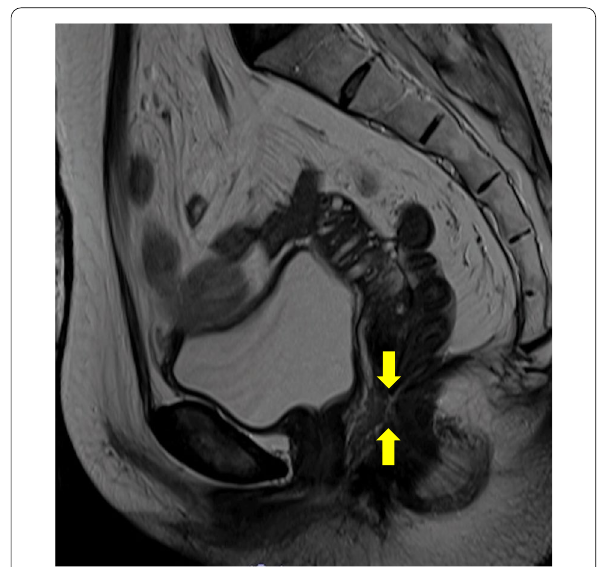
Fig. 2 Magnetic resonance imaging shows a fistula between the rectum and vagina (arrows). No pelvic abscesses or recurrent tumors are